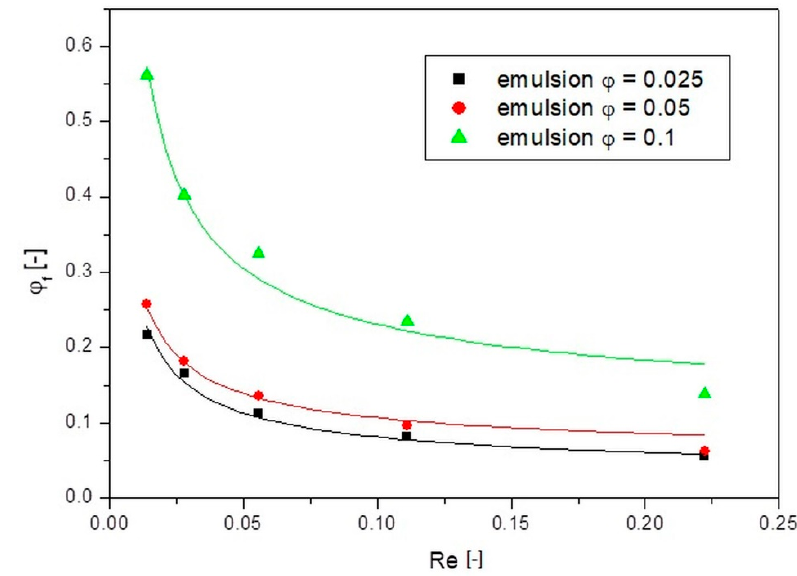
Figure 6. Dependences of the compaction ratio on the Reynolds number for different emulsion concentrations.